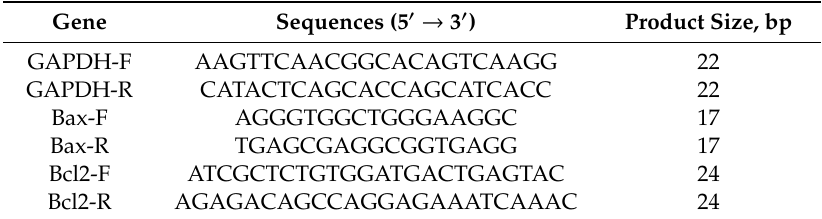
Table 2. Oligonucleotide sequences of interest and reference